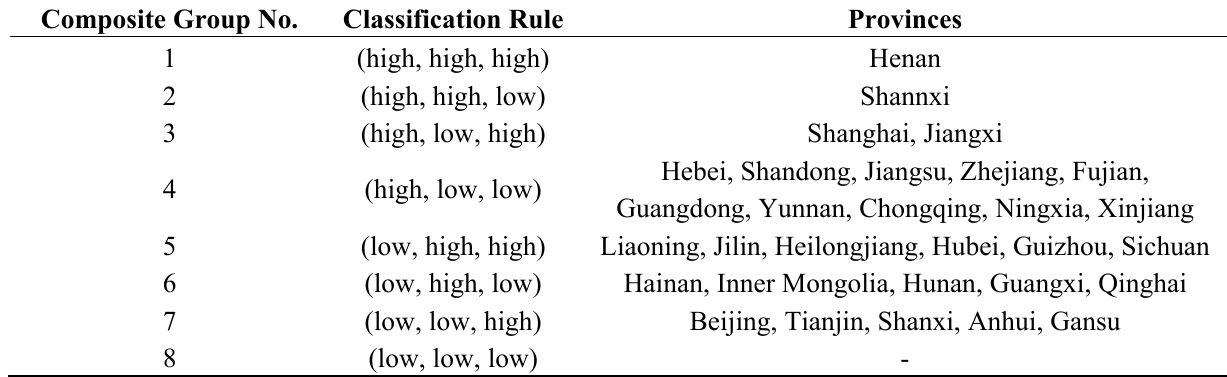
Table 2. Classification of provinces based on the normalized contribution rates of EXP , INC , and INT from 2001 to 2011. Composite Group No. Classification